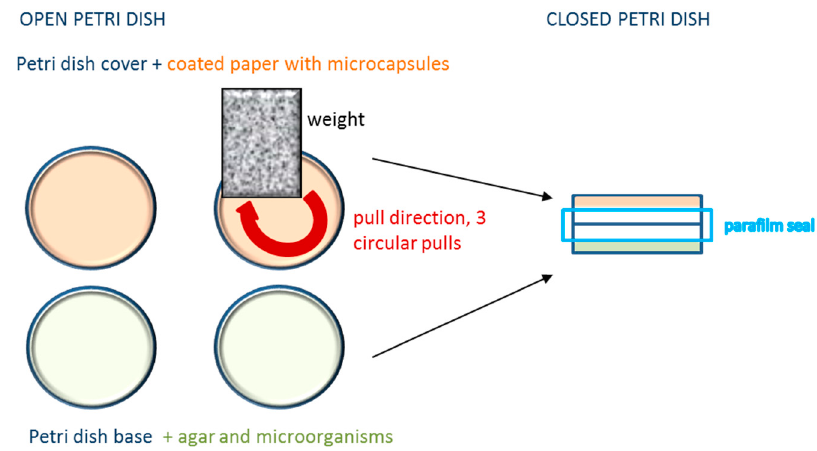
Figure 3. Mechanical activation of coated papers containing citronella oil microcapsules with weight pulling test before antimicrobial testing in Petri dishes.